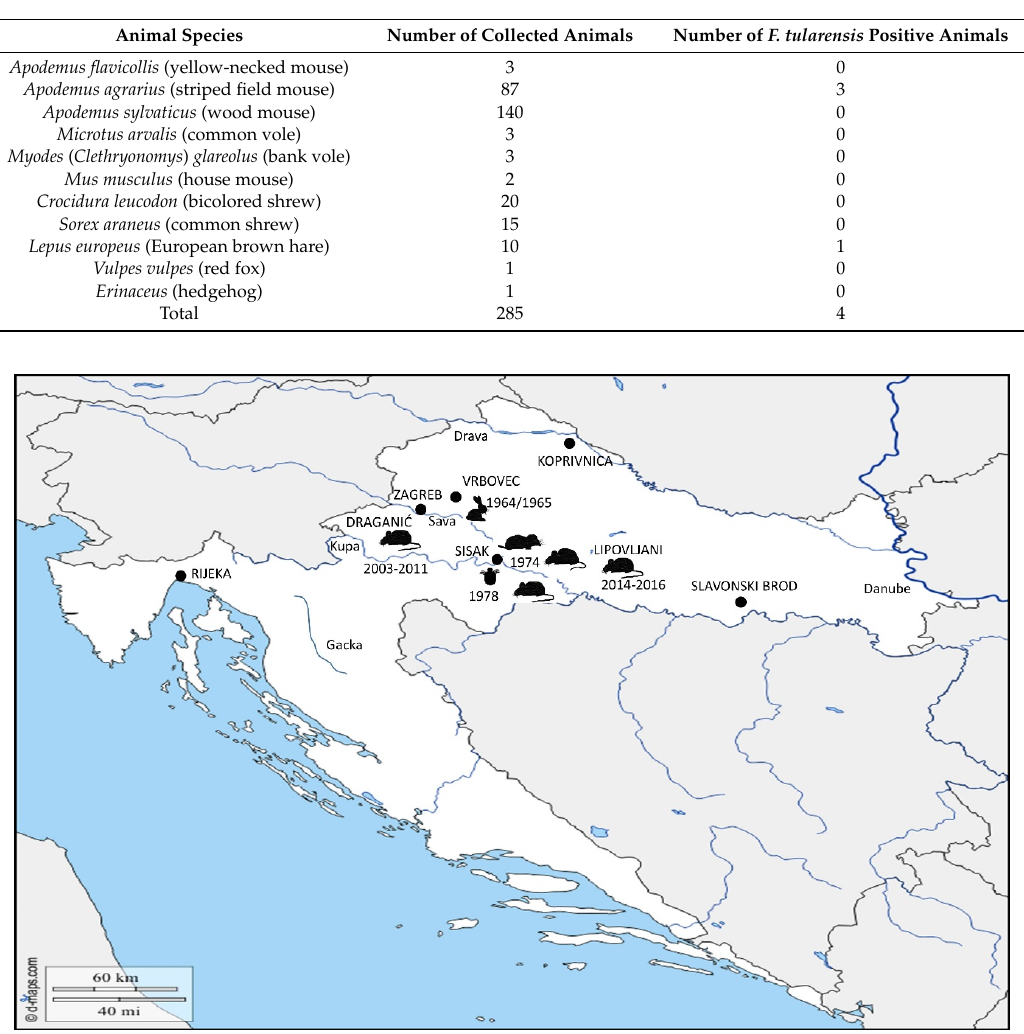
Figure 3. Epizooty of F. tularensis throughout the years in Croatia. Epizooty among the hare